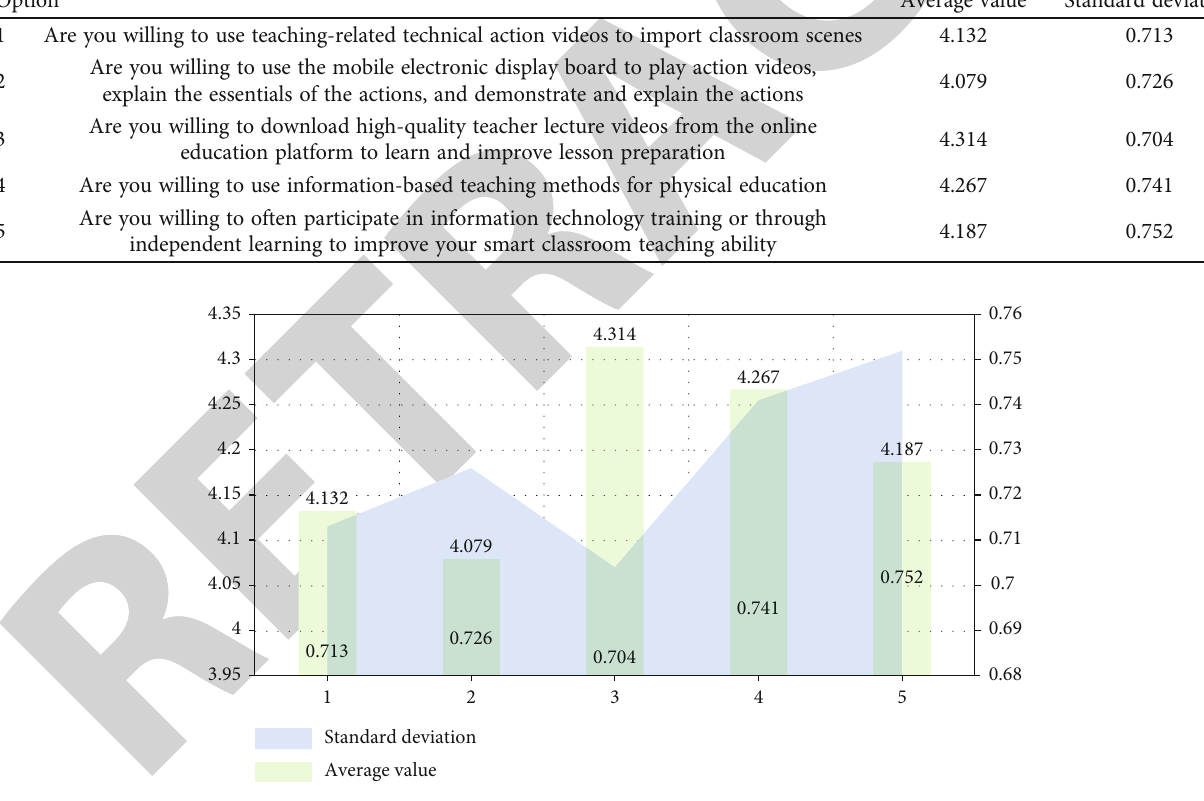
Figure 6: Attitudes of college PET towards smart physical